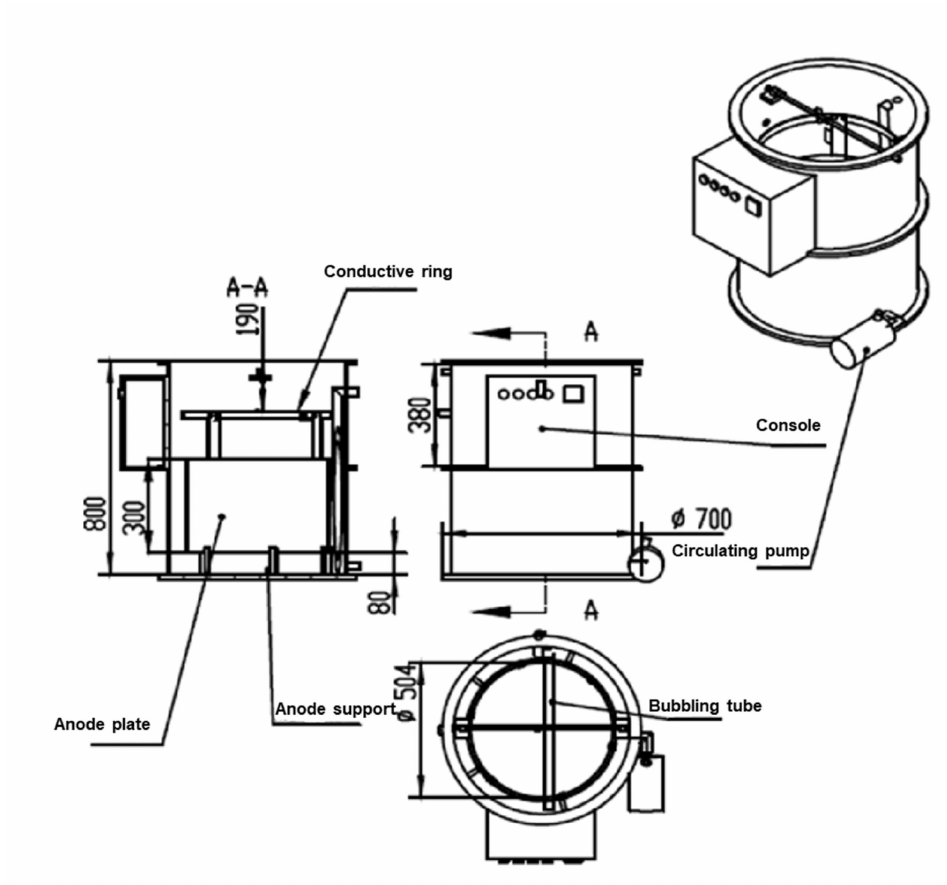
Figure 5. Structural diagram of electrophoretic deposition